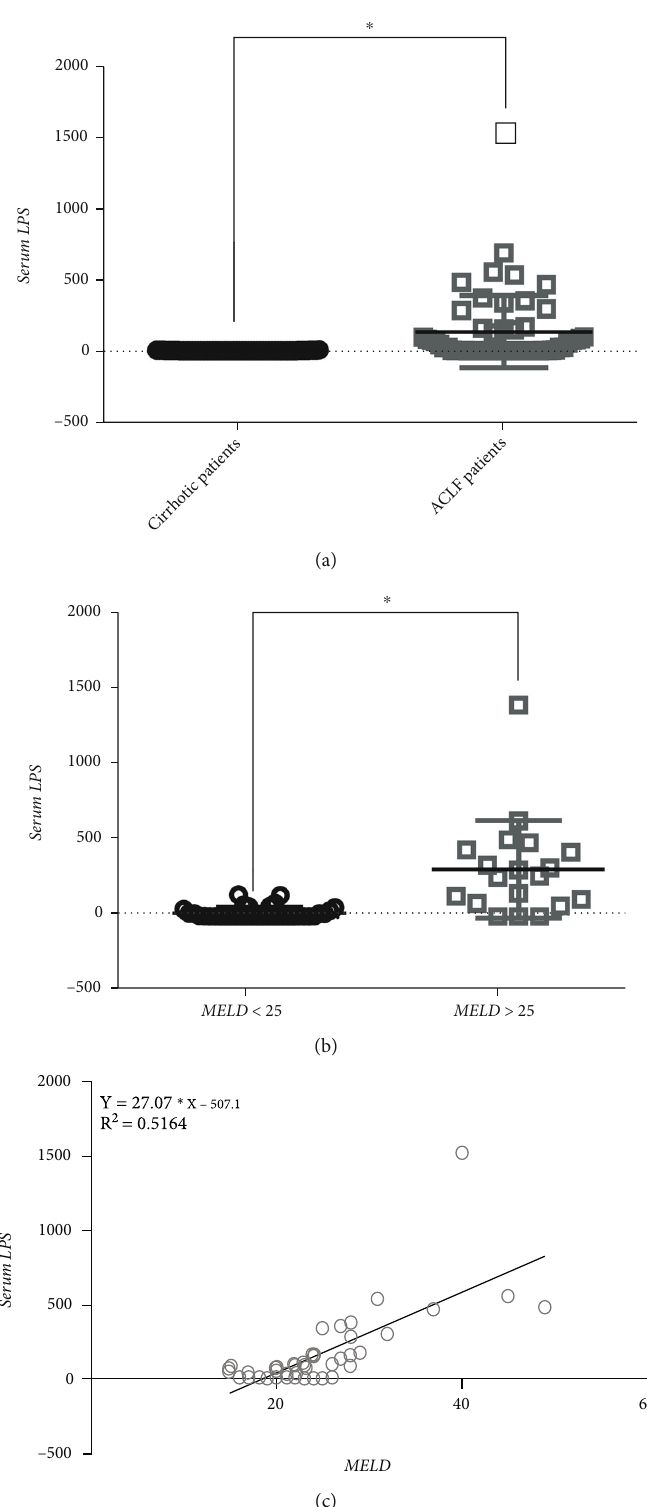
Figure 1: Increased serum LPS level is associated with poor prognosis of ACLF. Plasma from acute-on-chronic liver failure (ACLF) patients at admission and from cirrhotic patients were tested for LPS. (a) LPS level in ACLF patients was signi fi cantly increased compared to cirrhotic controls. (b) ACLF patients with MELDscore > 25 displayed higher LPS level compared to patients with MELDscore ≤ 25 ; (c) Positive correlation between serum LPS level and MELD score. ∗ P < 0 : 01